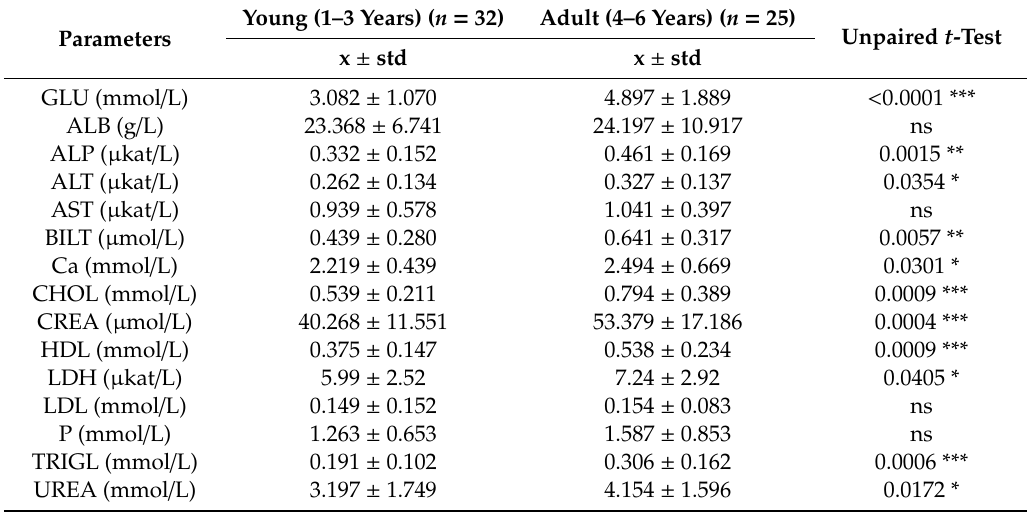
Table 2. A comparison of the age groups of the animals in terms of the selected biochemical parameters.